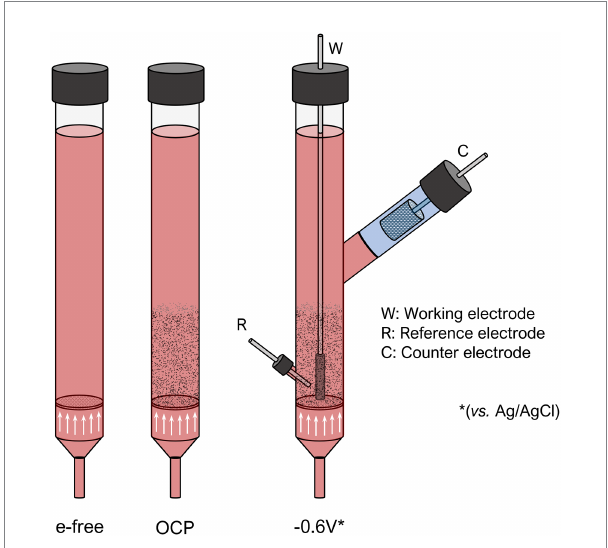
FIGURE 2 Scheme of the experimental set-up used for the fluid-cathode